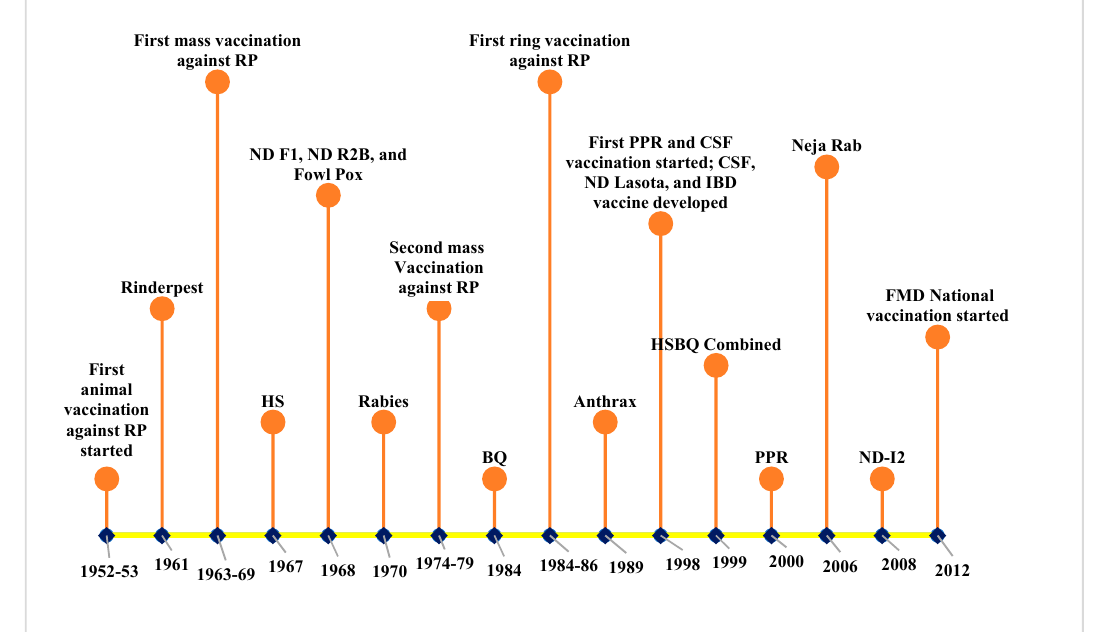
Figure 1. History of vaccination and vaccine production for livestock and poultry in Nepal.